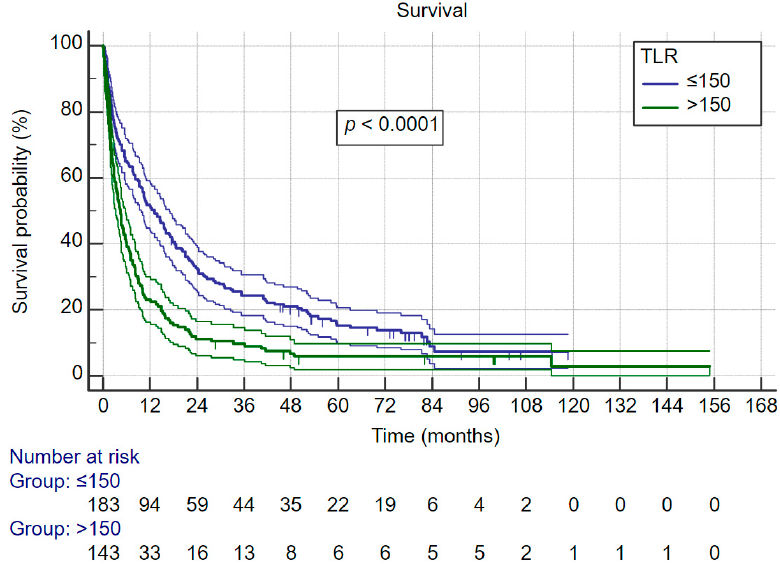
Figure 5. Kaplan–Meier survival curves for whole cohort, split by thrombocyte–lymphocyte ratio categories.